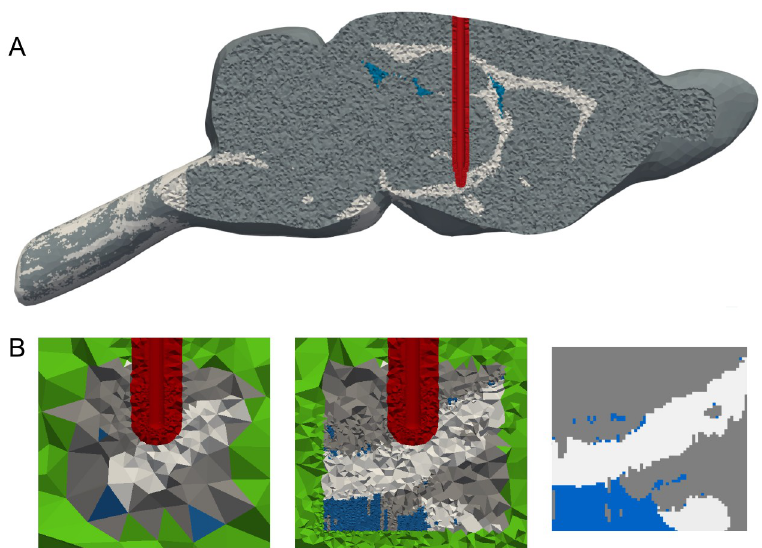
Fig 5. Distribution of the rat brain tissue [13], mapped onto a tetrahedral mesh using OSS-DBS. Grey and white matter are depicted with the corresponding colors, CSF is shown in blue and the encapsulation layer in red. The electrode lead is considered to be a perfect conductor and subtracted from the computational domain. (A) Tissue map for the whole brain. (B) Local mapping of the tissue before (left) and after (center) CSF refinement. The unmapped cells are depicted in green. For comparison, the segmented MRI data are shown on the